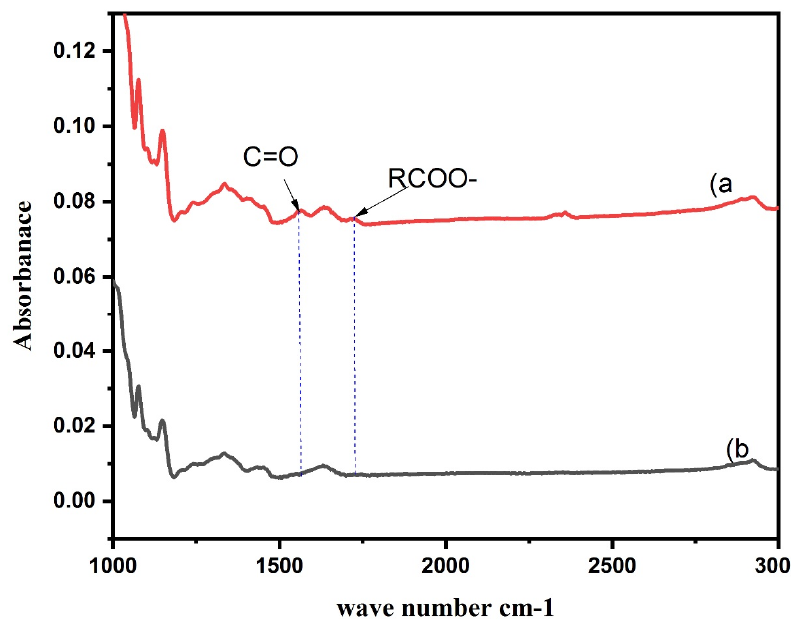
Figure 1. FT-IR spectra of ( a ) Osan-corn starch and ( b ) native corn starch.